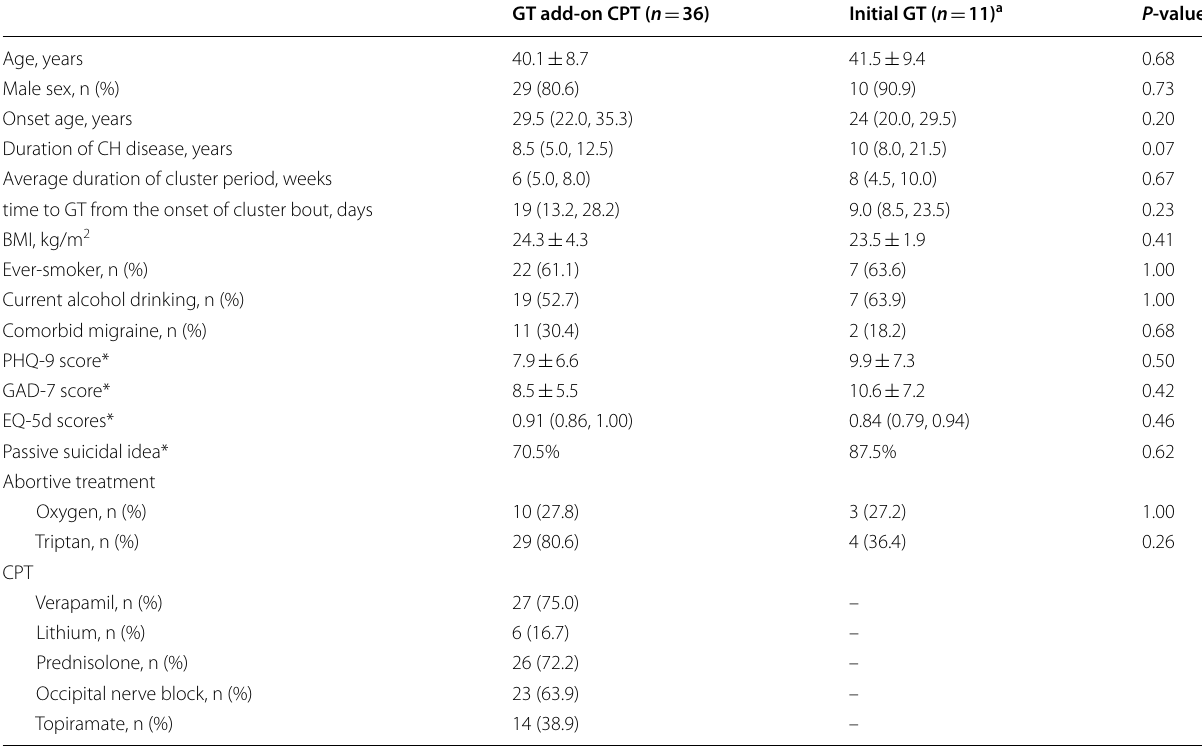
Table 1 Baseline characteristics of the patients with episodic cluster headache according to the timing of 240 mg of galcanezumab therapy